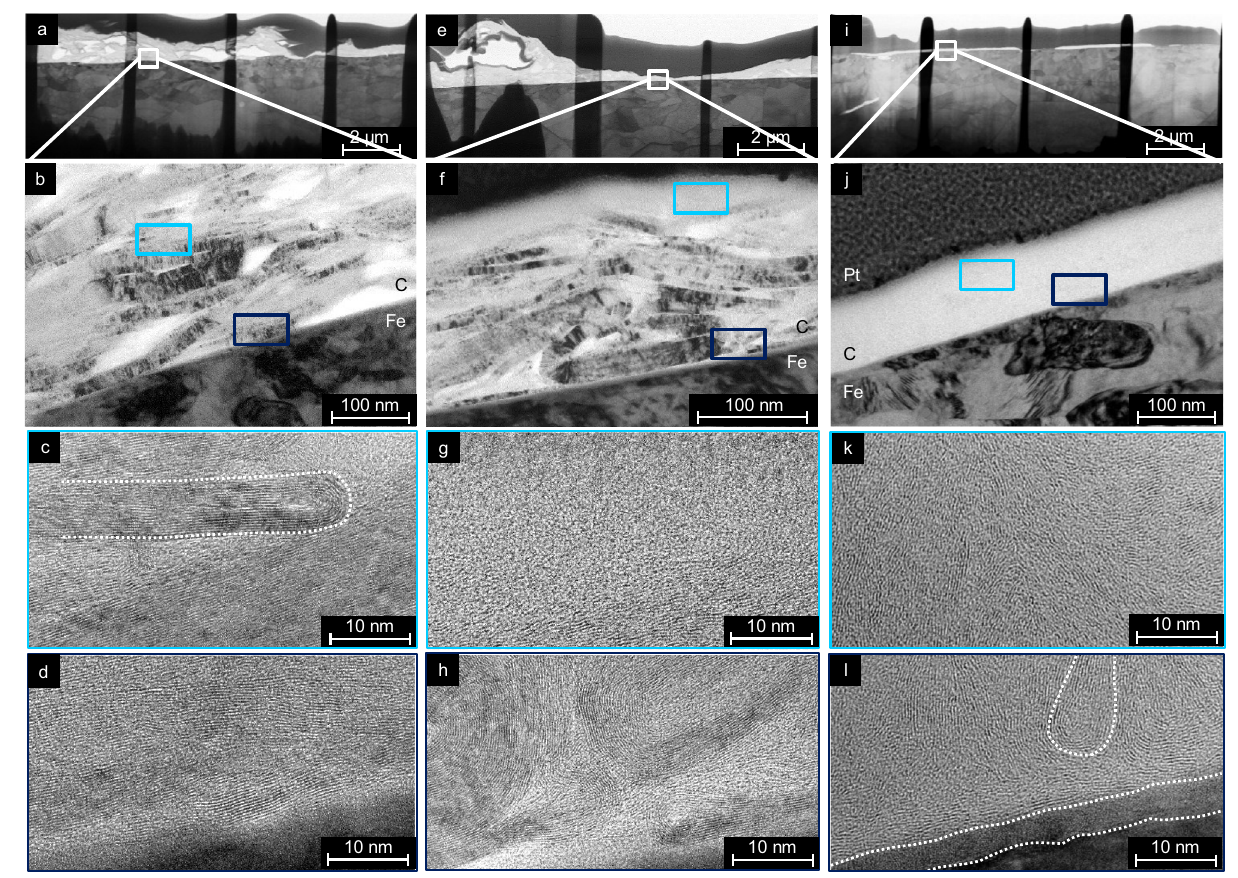
Fig.4|Bright fi eldtransmissionelectronmicroscopy(BF-TEM,upperhalf)and high-resolution transmission electron microscopy (HR-TEM, lower half) ima- ges. Taken from TEM lamella prepared in an unworn region ( a – d ), after sliding under 50MPa and in ≤ 5% RH humidity ( e – h ), and after sliding under 1GPa and in